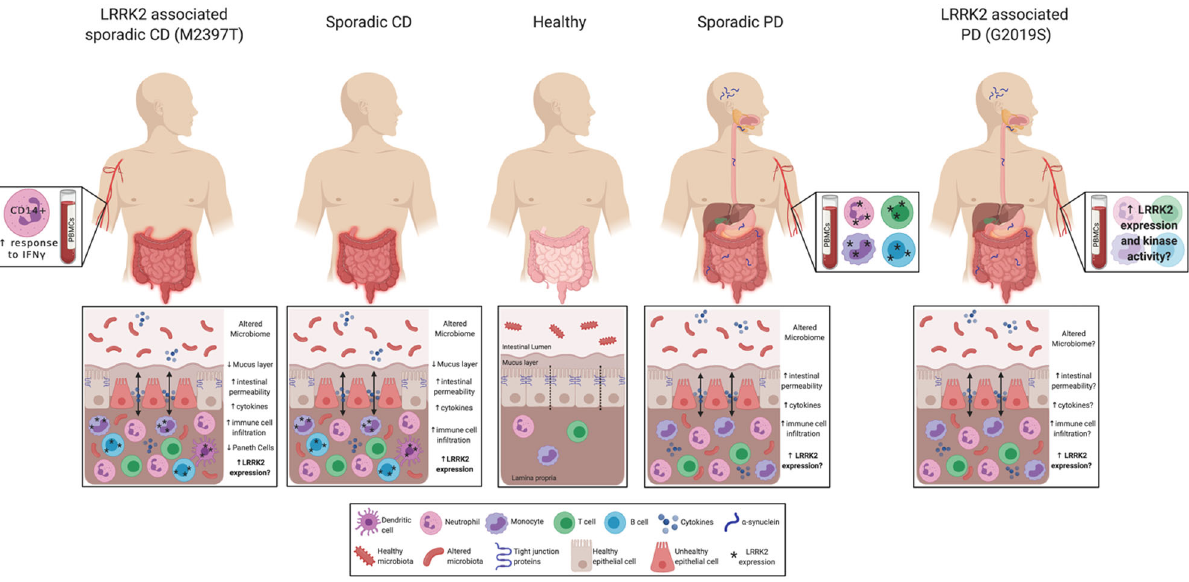
Fig. 1 LRRK2 immune cell expression at the interface of PD and CD. PD and CD exhibit very similar intestinal phenotypes with altered microbiome, increased intestinal permeability, cytokine secretion, and immune cell in fi ltration. While LRRK2 expression is increased in speci fi c immune cells in the in fl amed intestine in sporadic CD, LRRK2 expression in intestinal immune cells from PD patients has not been assessed. However, LRRK2 expression is increased in sporadic PD patient PBMCs, and CD14 + monocytes from LRRK2 M2397T CD patients have increased responses to IFN γ . While little is known about the LRRK2 expression and activity in the GI and peripheral immune systems of LRRK2 G2019S PD patients, we hypothesize that they will present with higher levels of LRRK2 expression and kinase activity and similar GI phenotypes as patients with non-LRRK2 PD. Given the current evidence for LRRK2 ’ s role in sporadic and genetic PD and CD, we posit that LRRK2 regulates in fl ammatory responses in the periphery and this is the reason its levels are increased in chronic in fl ammatory conditions which may serve as a potential therapeutic. Figure created with